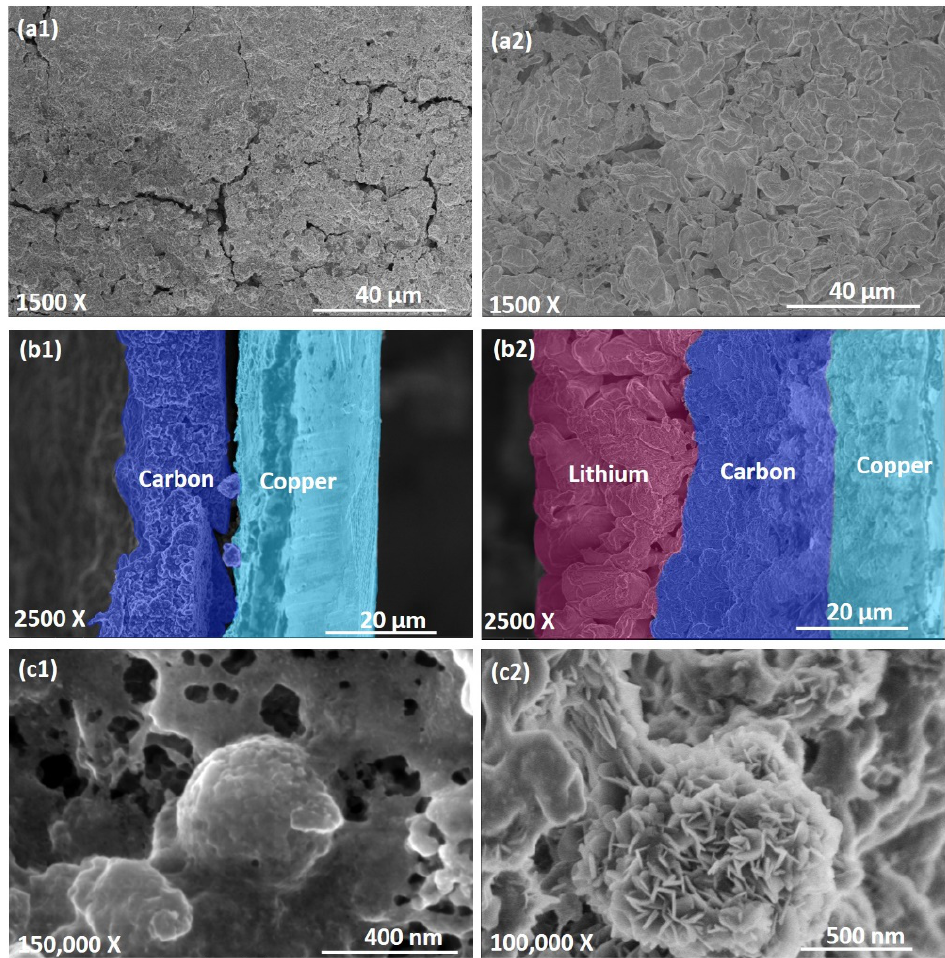
Figure 2. SEM images and X-ray maps of PHCCSs@Cu anode (core diameter: shell thickness = 110 nm: 60 nm) in the charged state after the fourth cycle, capacity limitations of 0.372 mAh ( a1 – c1 ) and 3.13 mAh ( a2 – c2 ), respectively. Top-view images ( a1 , a2 ), cross-sectional images ( b1 , b2 ), and magnified images of carbon particles ( c1 , c2 ).